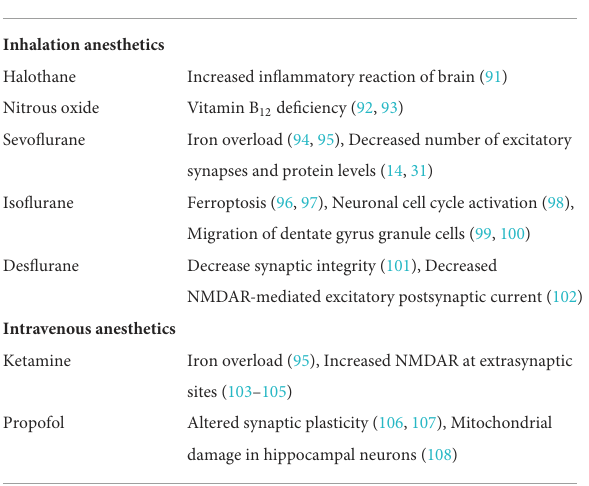
TABLE 1 Related studies on neurotoxicity of common general anesthetics.